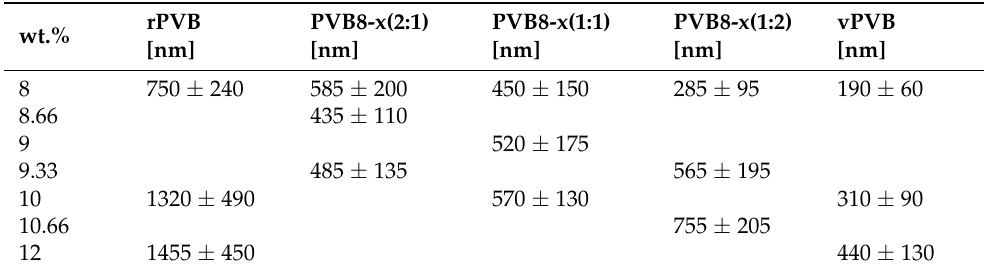
Figure 8. The histograms of the individual PVB blends with normal distribution. Table 3. Mean nanofiber diameters (including standard deviations) of recycled, blended and virgin PVB nanofibers (x = 8, 10,